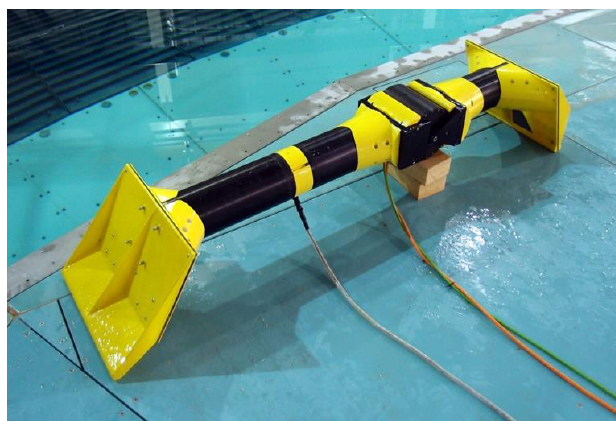
Fig. 4. The Mocean M100 WEC 1/20 th scale model.